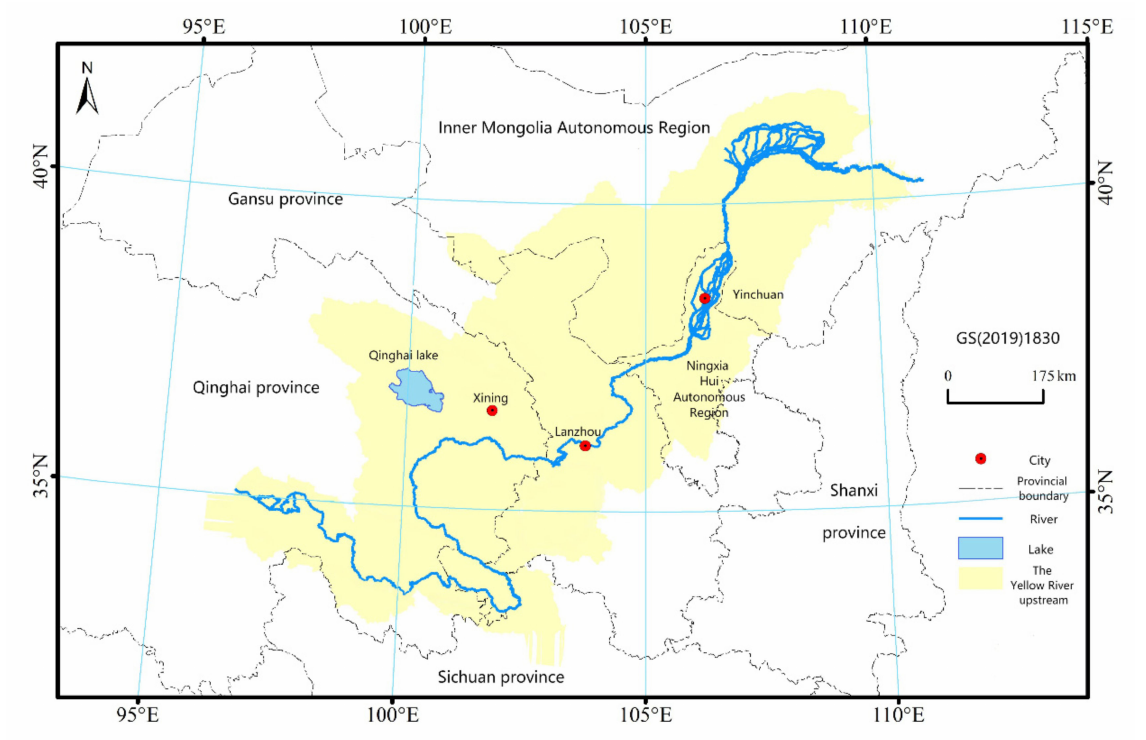
Figure 1. Schematic diagram of the upper Yellow River